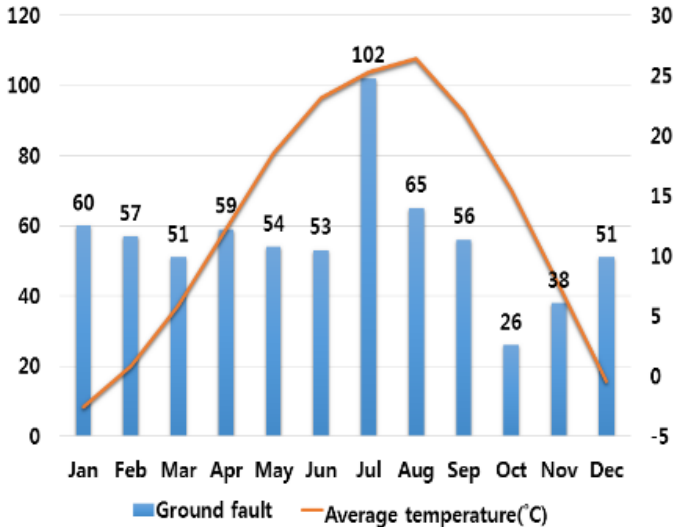
Figure 1. Correlation between the number of fires caused by ground fault and the average temperature on a monthly basis.